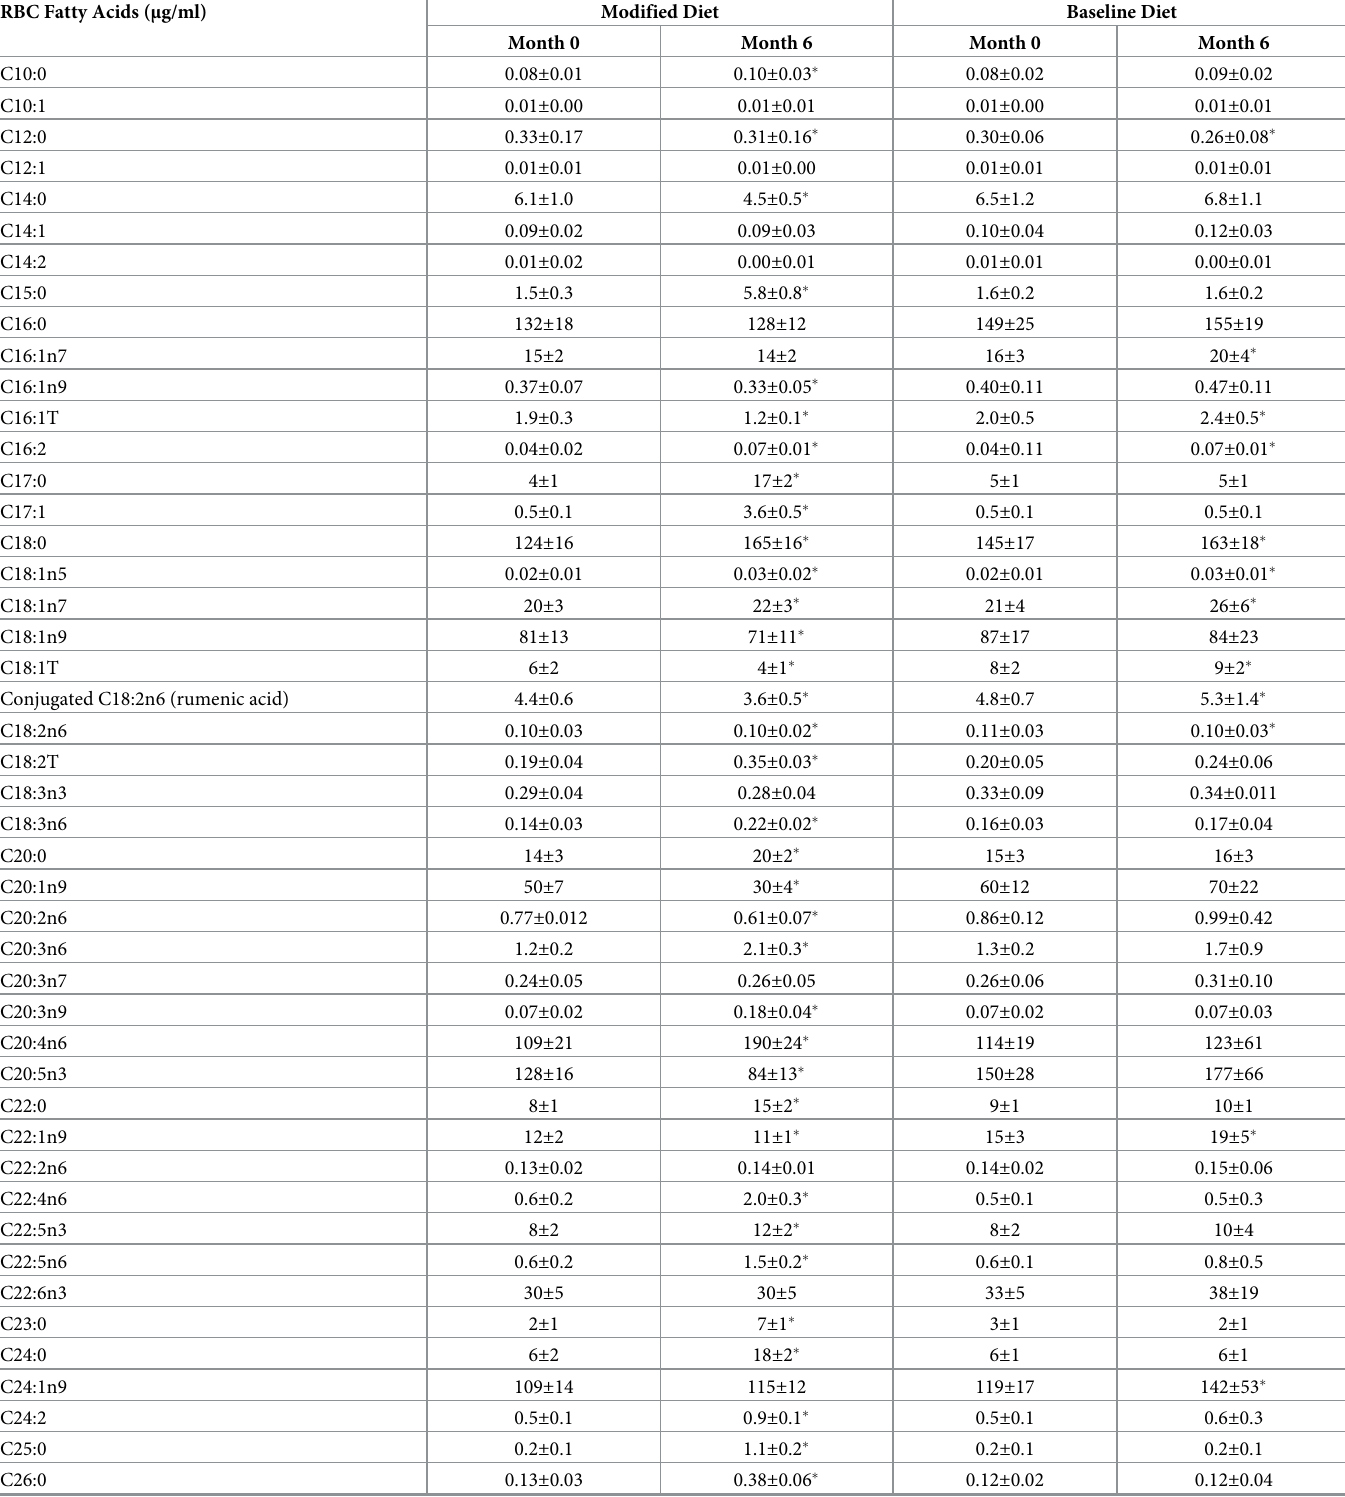
Table 7. Comparisons of baseline and final erythrocyte total fatty acid values in bottlenose dolphins ( Tursiops truncatus ) fed a modified versus baseline diet. RBC Fatty Acids ( μ